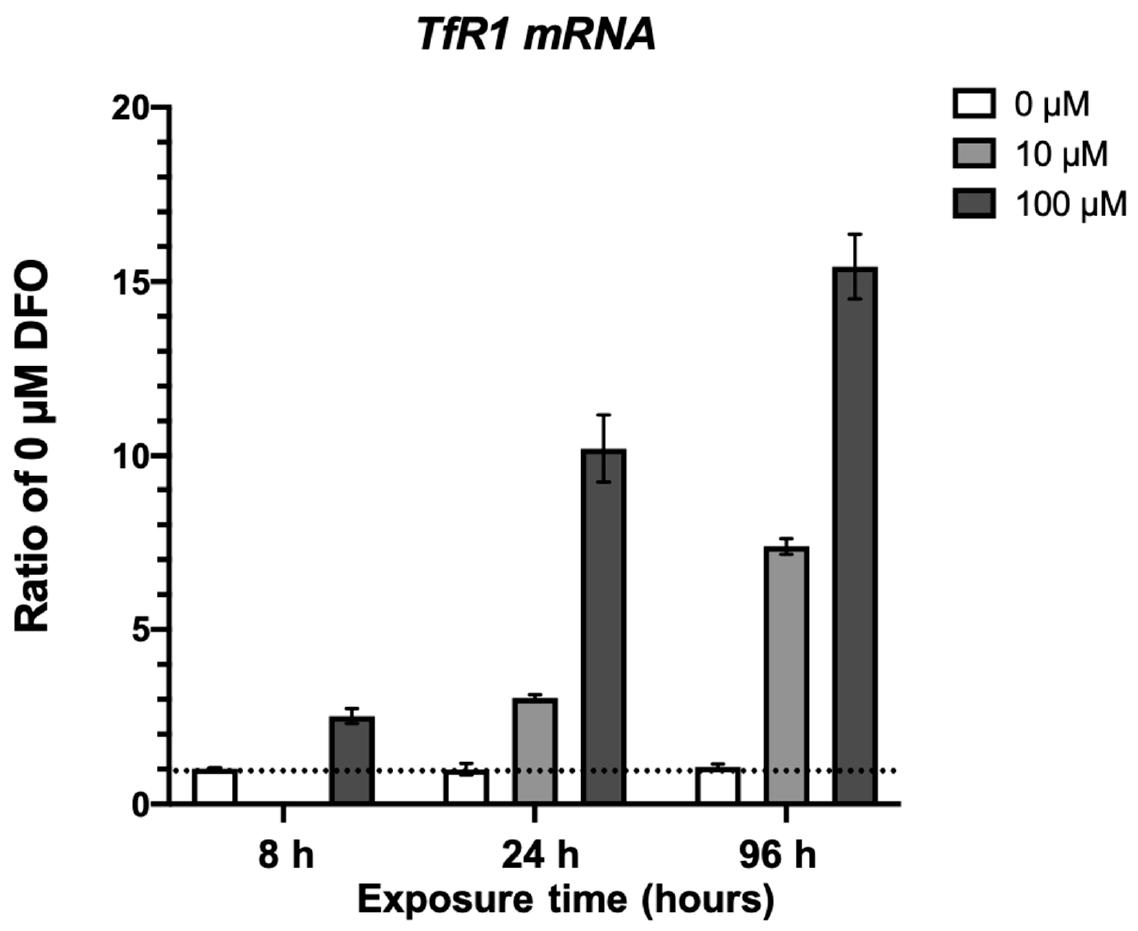
Figure 1. Quantitative PCR analysis of TfR1 expression. HT22 cells were treated with 10 or 100 µ M iron chelator deferoxamine (DFO) for 8, 24, and 96 h. The cellular iron deficiency was assessed by the upregulation of transferrin receptor 1 using quantitative real-time PCR. Samples (n = 3/treatment) were analyzed in duplicates and TATA-box binding protein (Tbp) or rps18 were used for normalization. Mixed-effects model 2-way ANOVA, p = 0.0001, F(2,16) =